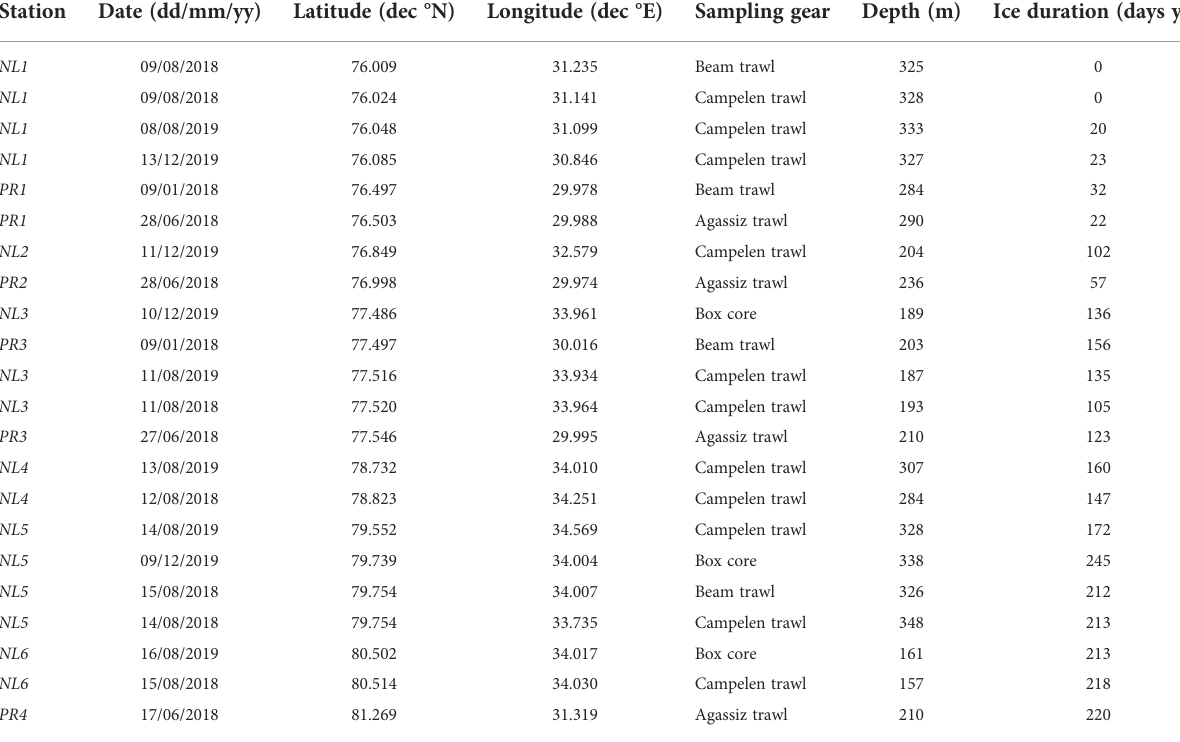
TABLE 1 Sampling information of the stations sampled in the Barents Sea.